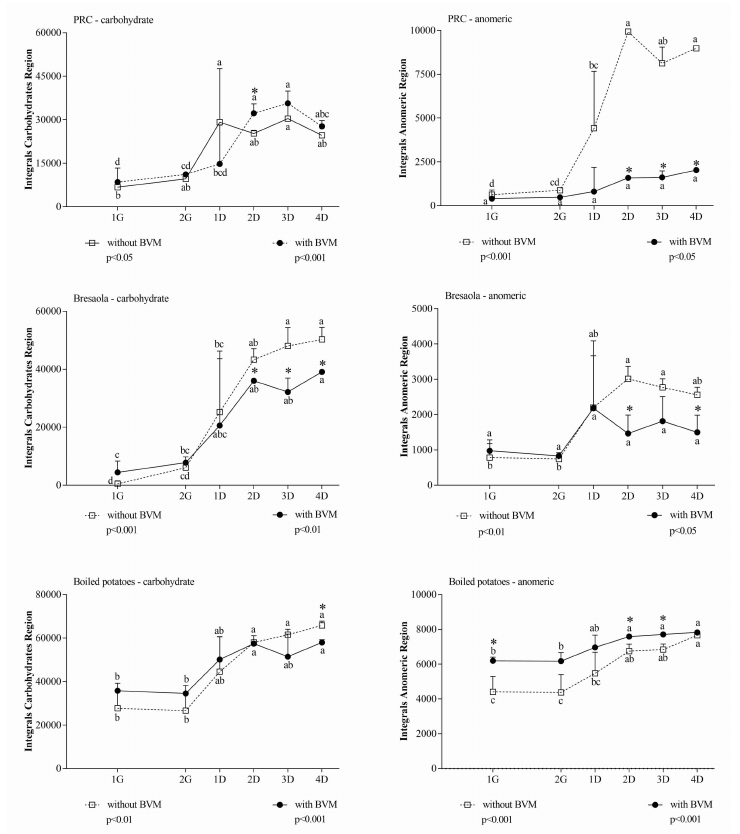
Figure 1. Integral area of carbohydrate and anomeric region of in vitro digested samples of Parmi- giano Reggiano cheese (PRC), Bresaola, and boiled potatoes. All data are means ± SD of at least three independent in vitro digestions. In each food matrix and spectral region, statistical analysis was by the one-way ANOVA with Tukey’s post hoc test to compare the release of soluble molecules at different time points (different letters indicate significant differences) and by the Student’s t -test to evaluate the effect of BVM at each time point (* at least p < 0.05).